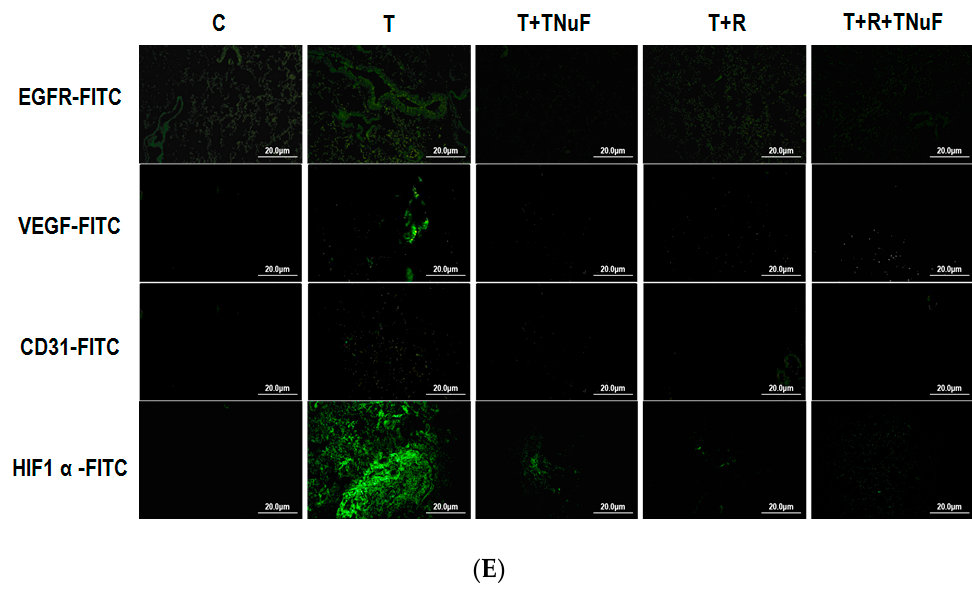
Figure 5. TNuF and/or plus irradiation affected lung metastatic colonization of LLC cells in C57BL/6JNarl mice. ( A ) Lung weight from the mice of each group at the end time-point. ( B ) Quantification of metastatic nodules present in the bilateral lungs of mice; each point represents an individual animal. ( C ) Lung appearance (up) and histology (H + E stain; down) in LLC inoculated C57BL/6JNarl mice. The solid tumors (indicated by arrows) were spotted on multiple sites in mice. Five representative samples are shown. ( D ) Correlation between lung weight and tumor nodule number in lungs. ( E ) Immunofluorescence analysis for lung tissues treated with TNuF and/or plus irradiation. Images are shown at ×200 magnification; ( F ) Protein expression levels that are quantified and expressed as a relative change to the LLC cell-inoculated group. Data were derived from three independent experiments and presented by mean ± SEM . * p < 0.05, *** p < 0.001 when compared to